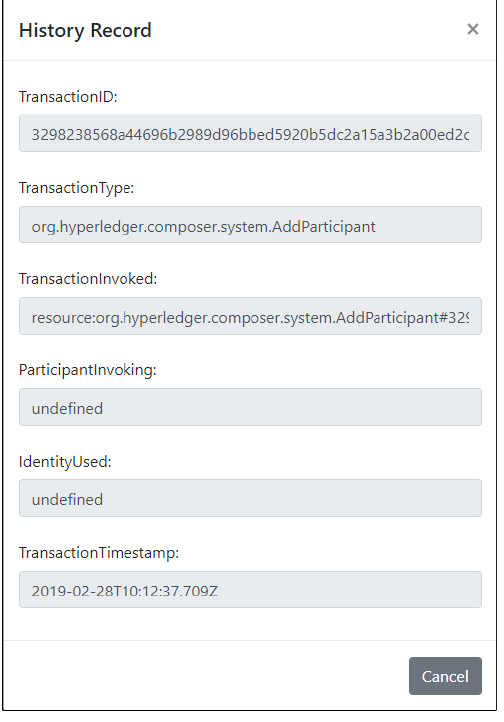
Figure 25. Detailed view of transaction